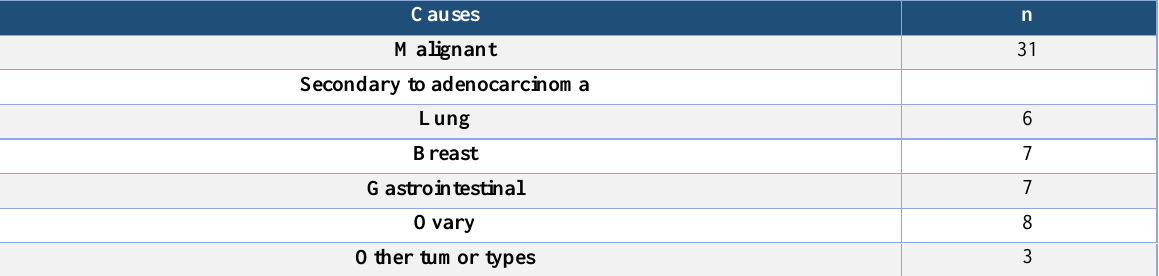
Table 4 . Distribution of Malignant Serosal fluids by confirmed